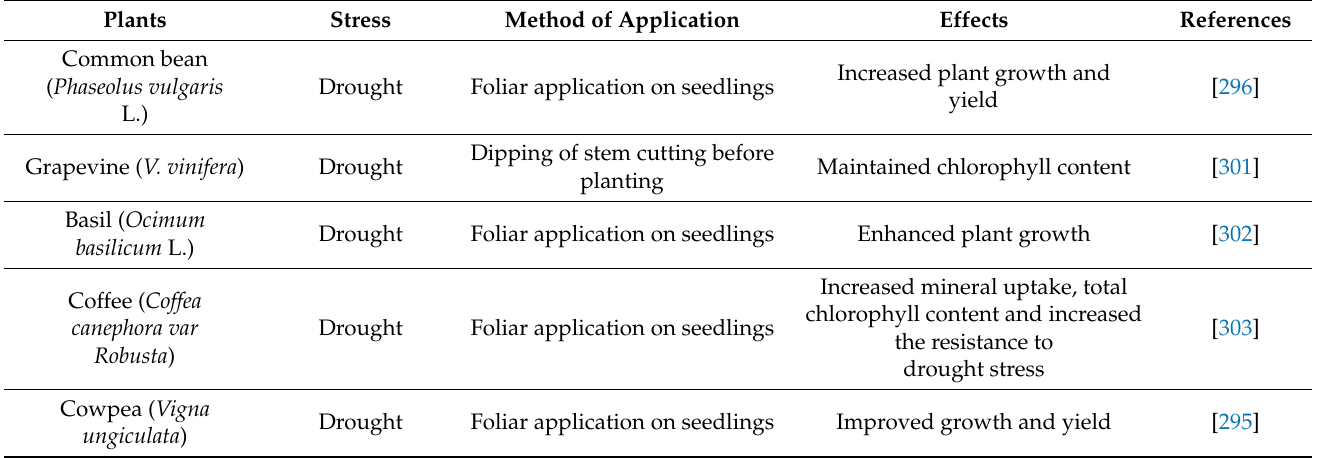
Table 5. Effective outcomes against diverse abiotic challenges were found with chitosan- treated